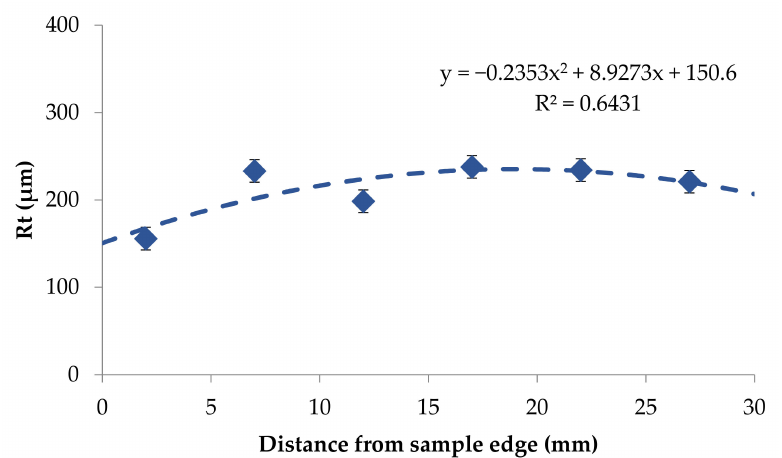
Figure 18. The relationship between the maximum height of the profile (R t ) and the distance on the edge 2 on the briquette back surface—left to right direction.